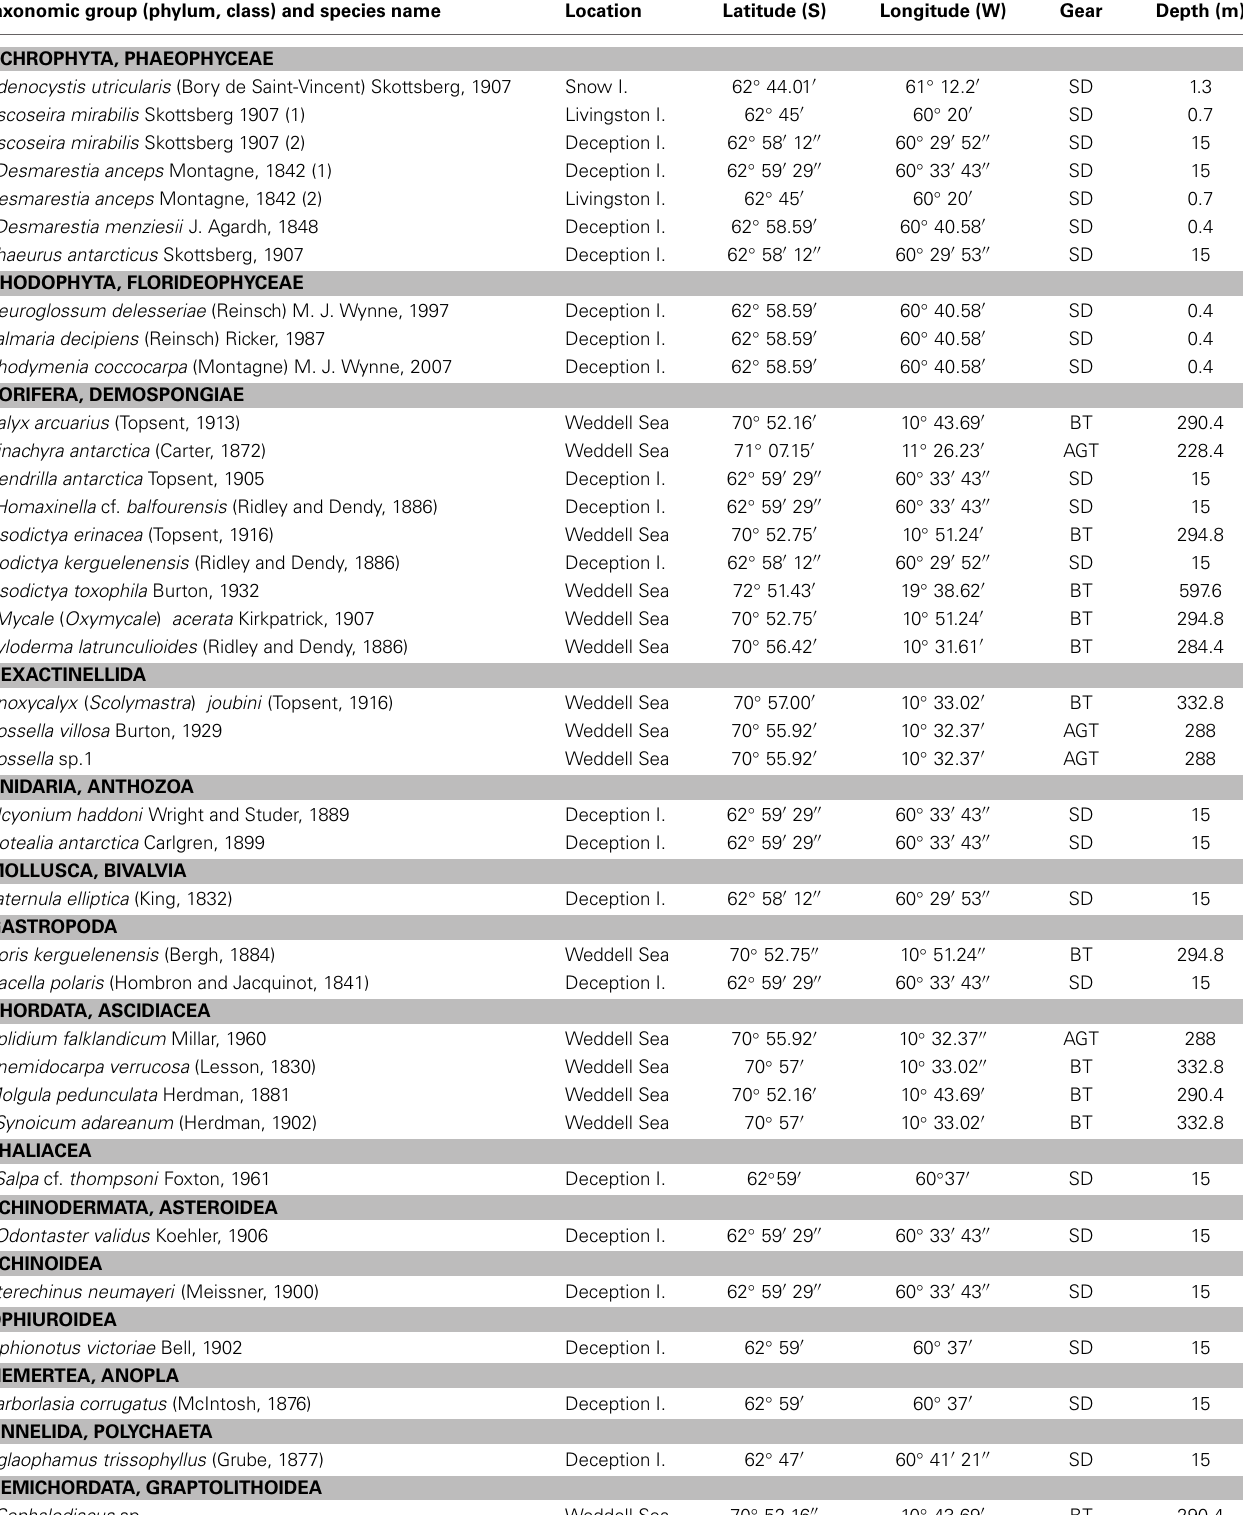
Table 1 | Data of the benthic algae and invertebrates used in this study, collected in the Weddell Sea and the vicinities of the South Shetland Islands (Deception, Livingston, and Snow Islands) during ANT XXI/2, ACTIQUIM-1, and ACTIQUIM-2 cruises. Taxonomic group (phylum, class) and species